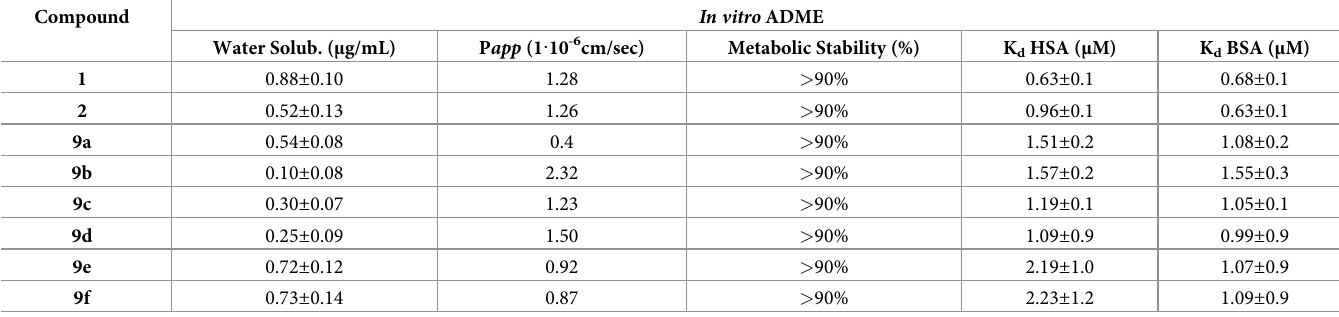
Values represent mean±S.D of three independent